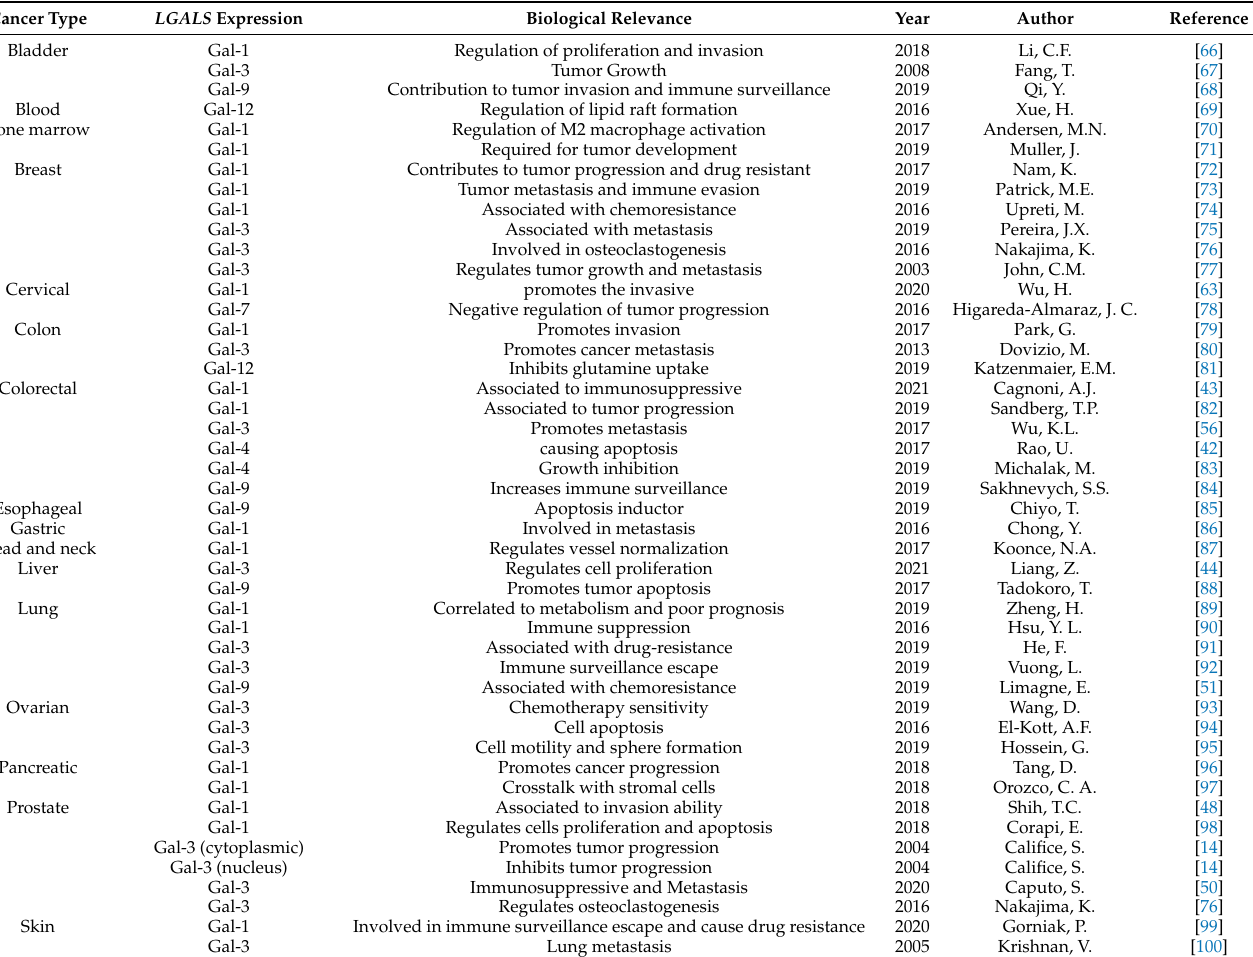
Table 3. Functions of LGALS in